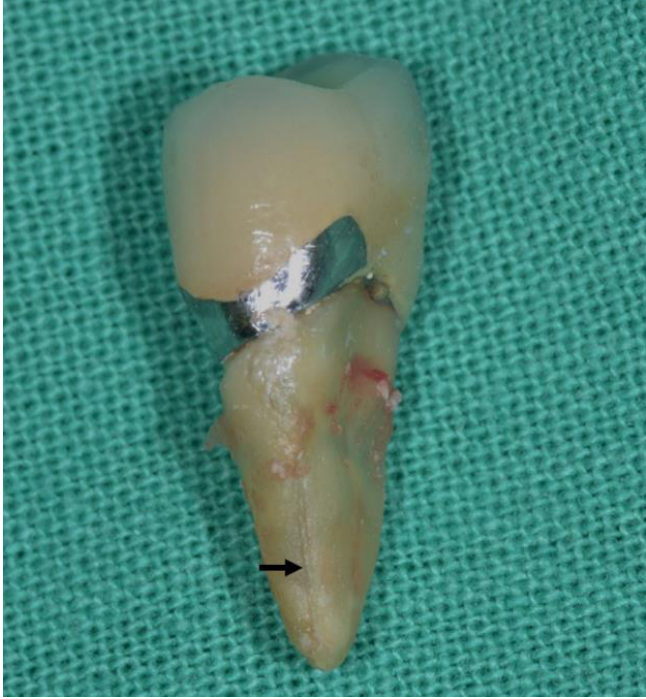
Figure 1. Roots with a cross-section of a smaller mesiodistal diameter and a deep oval or flattened shape are more susceptible to VRFs. The black arrow indicated the appearance of VRF.